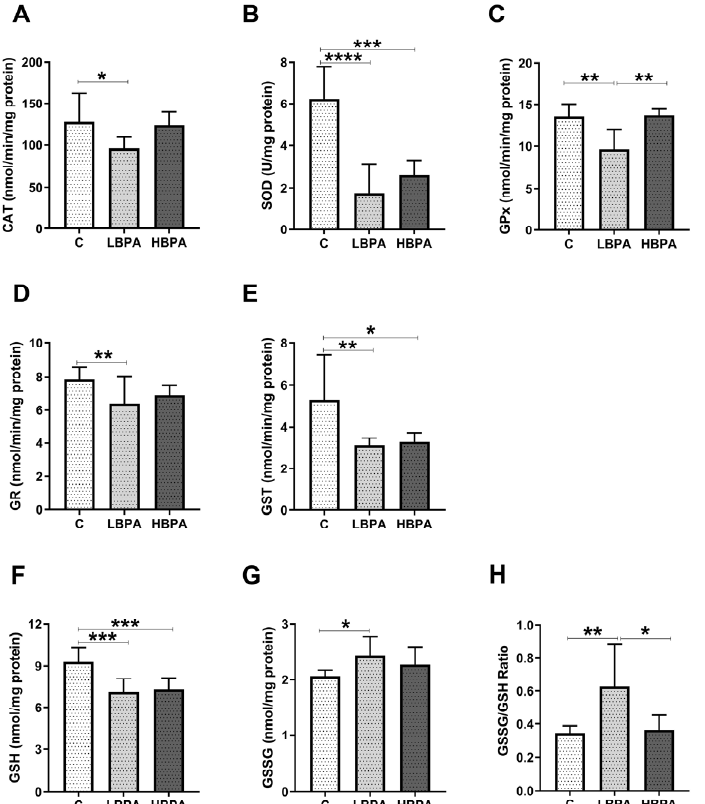
Figure 6. Effects of perinatal exposure to BPA on antioxidant enzyme activities and glutathione concentrations in livers from female PND6 offspring. ( A ) Enzymatic activity of catalase (CAT) in nmol/min/mg protein; ( B ) superoxide dismutase (SOD) in U/mg protein; ( C ) glutathione peroxidase (GPx) in nmol/min/mg protein; ( D ) glutathione reductase (GR) in nmol/min/mg protein; ( E ) glutathione S-transferase (GST) in nmol/min/mg protein. ( F ) Concentration of reduced glutathione (GSH) in nmol/mg protein; ( G ) concentration of oxidized glutathione (GSSG) in ng/mg protein. ( H ) GSSG/GSH ratio. Data represent mean ± SD. n = 12 control PND6 offspring; n = 12 LBPA PND6 offspring; n = 12 HBPA PND6 offspring (two replicates for each sample). Statistical significance was determined by one-way ANOVA. * p < 0.05; ** p < 0.01; *** p < 0.001; **** p < 0.0001.